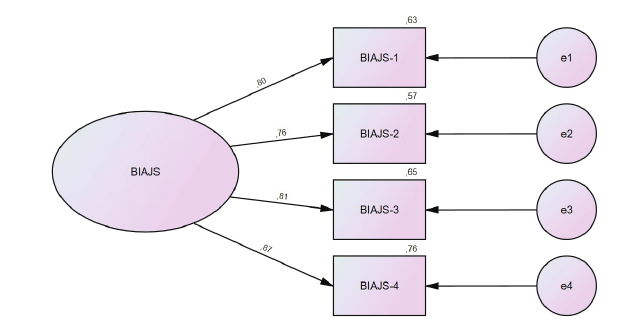
Figure 2 - Graphical representation of the Kazakh version of the BIAJS model